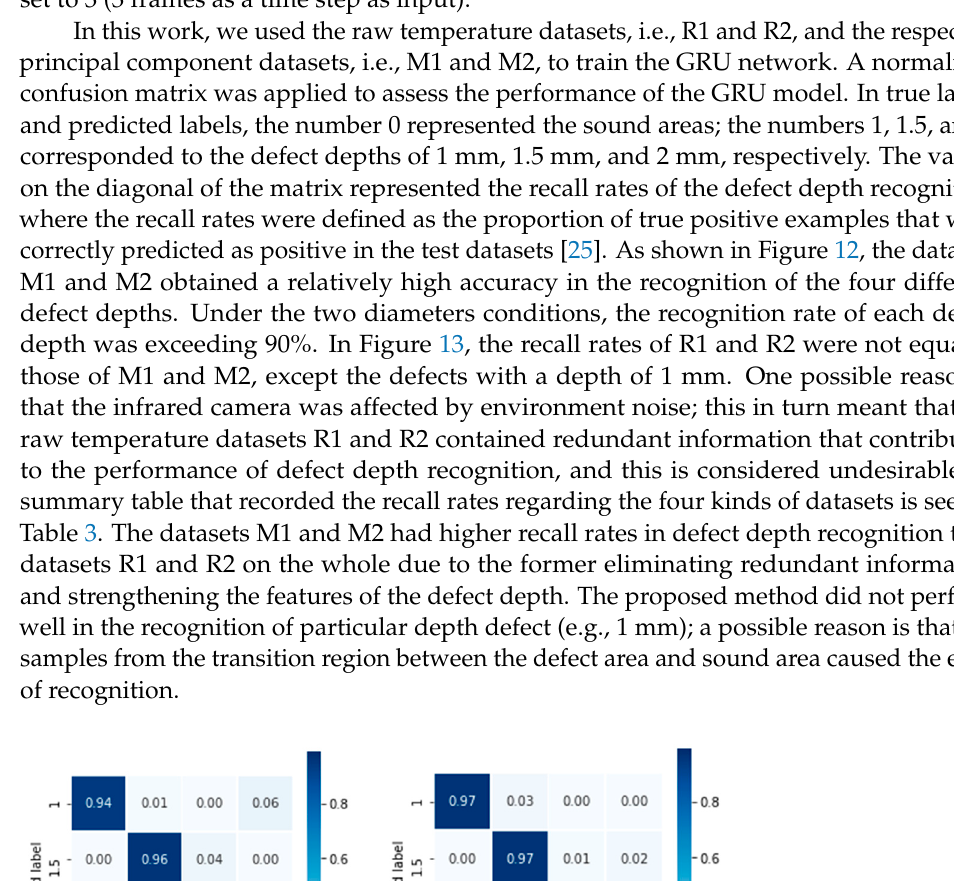
Figure 11. The result processed by PCA method: PCT1, PCT2, and PCT3.